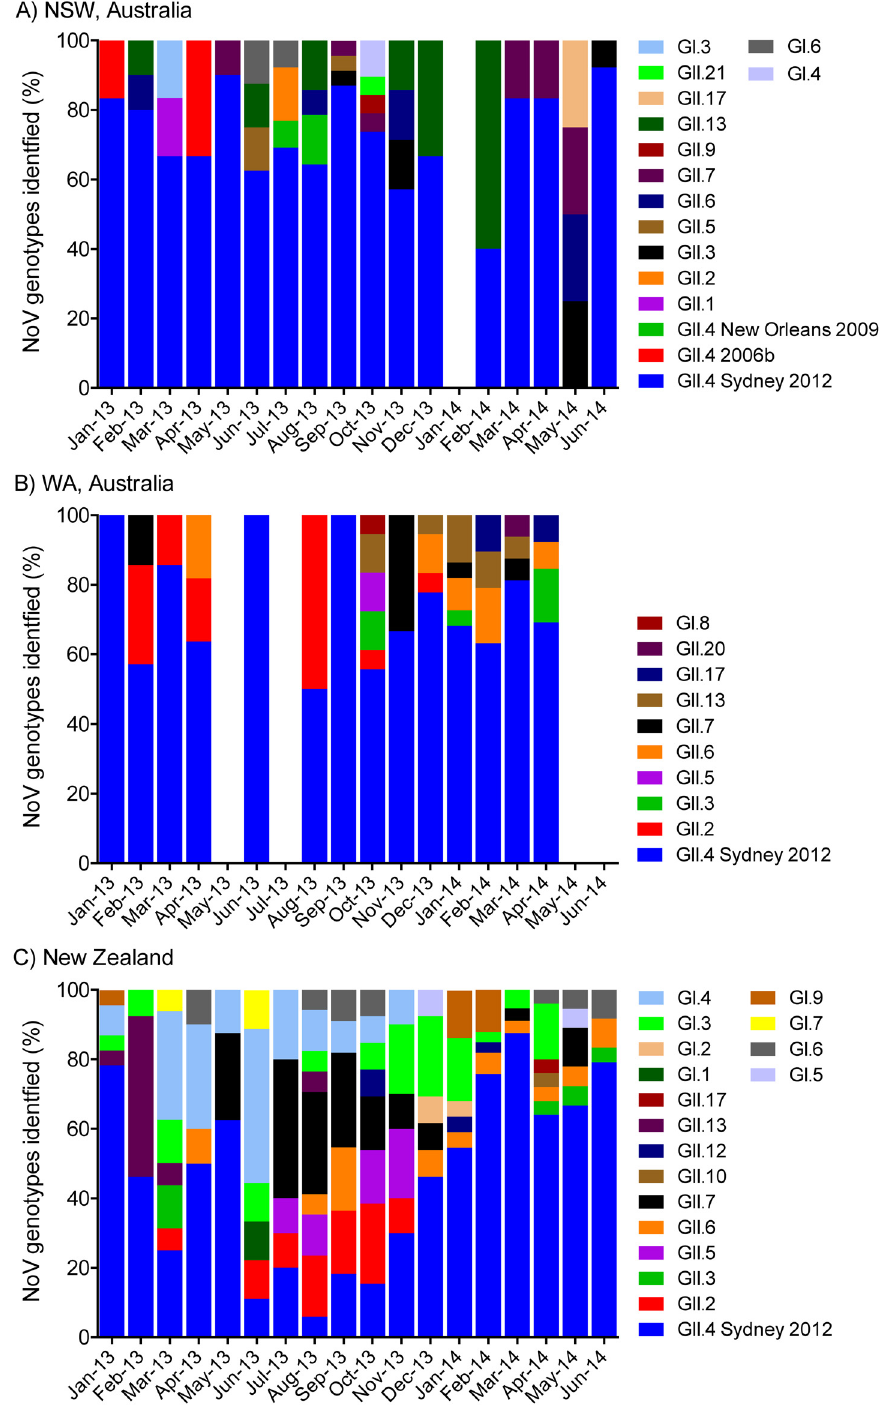
Fig 2. Monthly proportion of NoV genotypes identified in Australia and New Zealand between January 2013 and June 2014. The prevalence of NoV capsid genotypes and specific GII.4 variants within the 634 NoV-positive samples were compared for NSW and WA, Australia (panel A and B, respectively) and New Zealand (panel C). Samples with unknown GI or GII capsid genotypes as well as mixed GI and GII infection are excluded in this analysis (n = 13). The percentage of each NoV capsid genotype (Y-axis) is plotted by month (X-axis). Different genotypes and GII.4 variants are labelled according to the legends provided